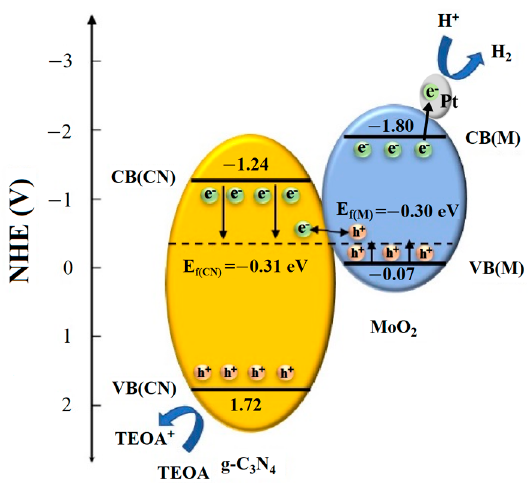
Figure 9. Schematic diagram of the photocatalytic HER mechanism over the g-C 3 N 4 /MoO 2 compo-